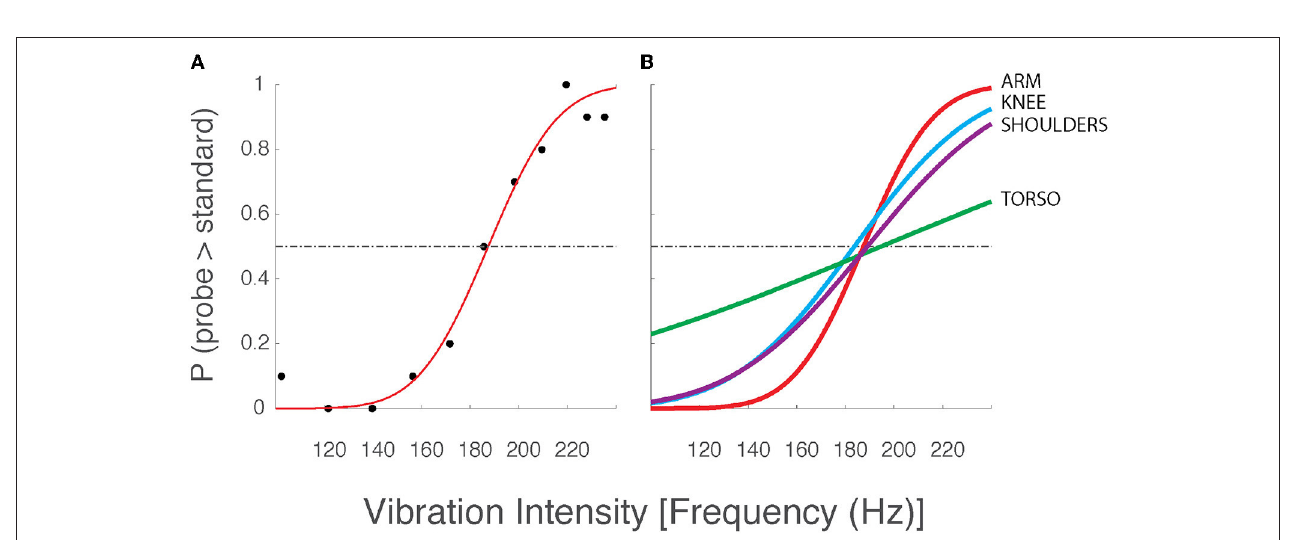
FIGURE 2 | Two-alternative forced choice data and best-fit psychometric curves from a selected participant from Experiment 1. (A) Data from a single testing block with vibration motors applied to the arm. Although vibration frequency covaries with amplitude in the ERM vibration motors used in this study (see Figure 1B ), we chose to report vibrotactile stimulus intensity only in terms of frequency for narrative simplicity. Black dots: the observed intensity at which the participant responded that the corresponding probe stimulus intensity was greater than the standard stimulus (186Hz). Red line: the best fit psychometric curve fit to the observed experimental data. Horizontal dashed line: chance probability. (B) Best fit psychometric curves from the same participant at the arm (red), knee (blue), shoulders (purple), and torso